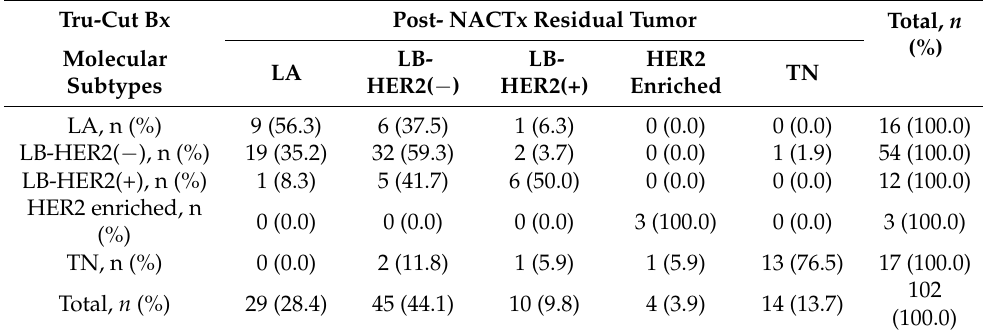
Table 6. Molecular subtypes of the patients before and after